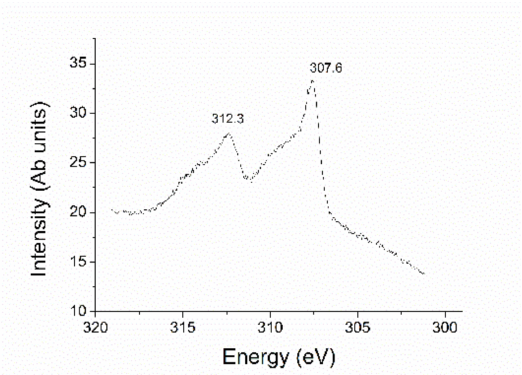
Figure 4. XPS spectrum of M1B.